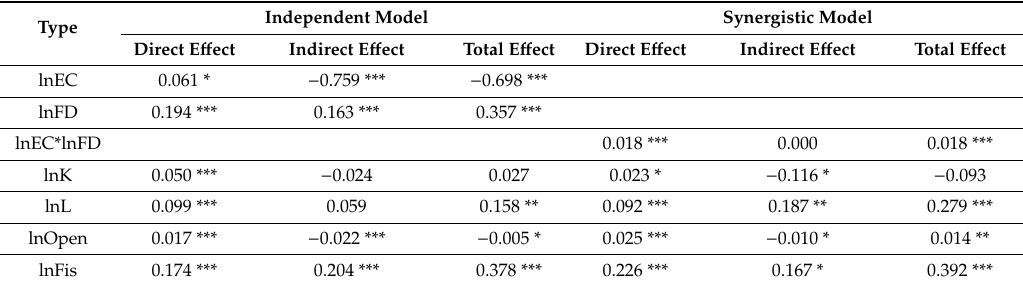
Table 2. Spatial e ff ect